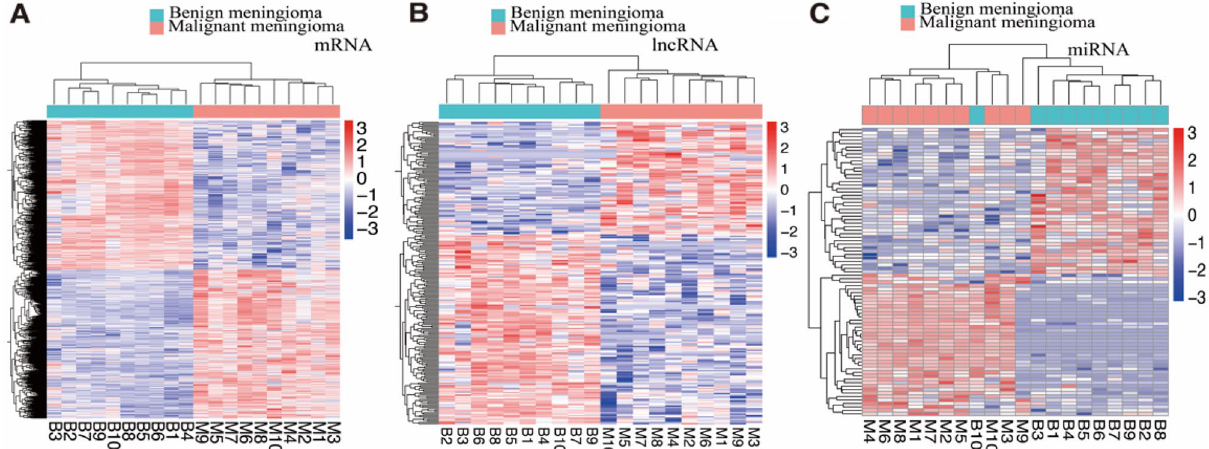
Figure 2. LncRNA, mRNA and miRNA expression profile changes between malignant group and benign group in meningioma. ( A , B , C ) Hierarchical clustering of all samples revealed the nonrandom partitioning of samples into two major group: one group containing ten malignant progression penetration samples and another group containing ten benign progression samples. Each column represents one sample and each row represents one lncRNA, mRNA and miRNA set. “ComplexHeatmap” R package (version 3.15) was used to graph the